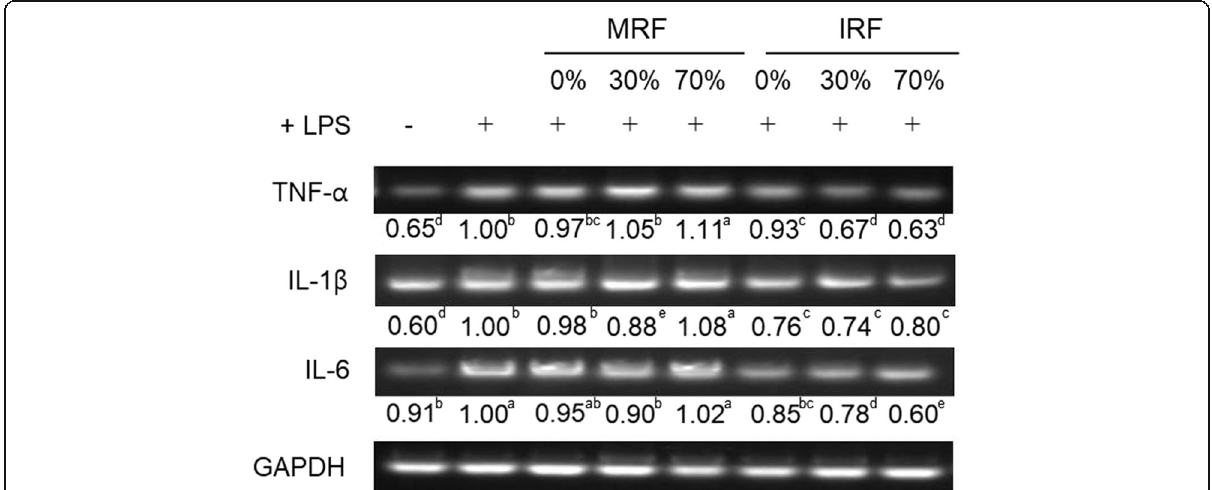
Fig. 3 Anti-inflammatory effect of Rubus coreanus fruit (RF) extracts on mRNA expression. Representative bands of tumor necrosis factor (TNF)- α , interleukin (IL)-1 β , and IL-6 are shown. Cells were treated with mature RF (MRF) and immature RF (IRF) at 200 μ g/mL for 1 h, followed by 1 μ g/mL LPS with extracts for 18 h. mRNA expressions were detected using reverse transcription-polymerase chain reaction (RT-PCR). The data depicted in the bend below as the means are an average of three similar and independent experiments. Means with different letters are significantly different at p < 0.05 by Tukey ’ s multiple comparison tests